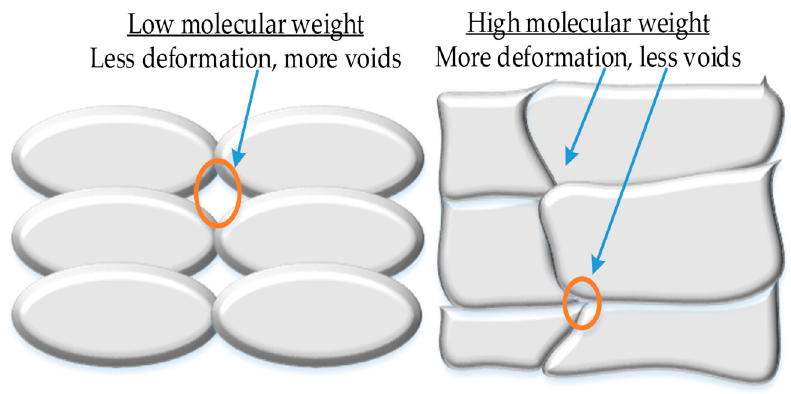
ff ects of molecular weight on di ff Figure 6. Illustration of effects of molecular weight on diffusion. Figure 6. Illustration of e